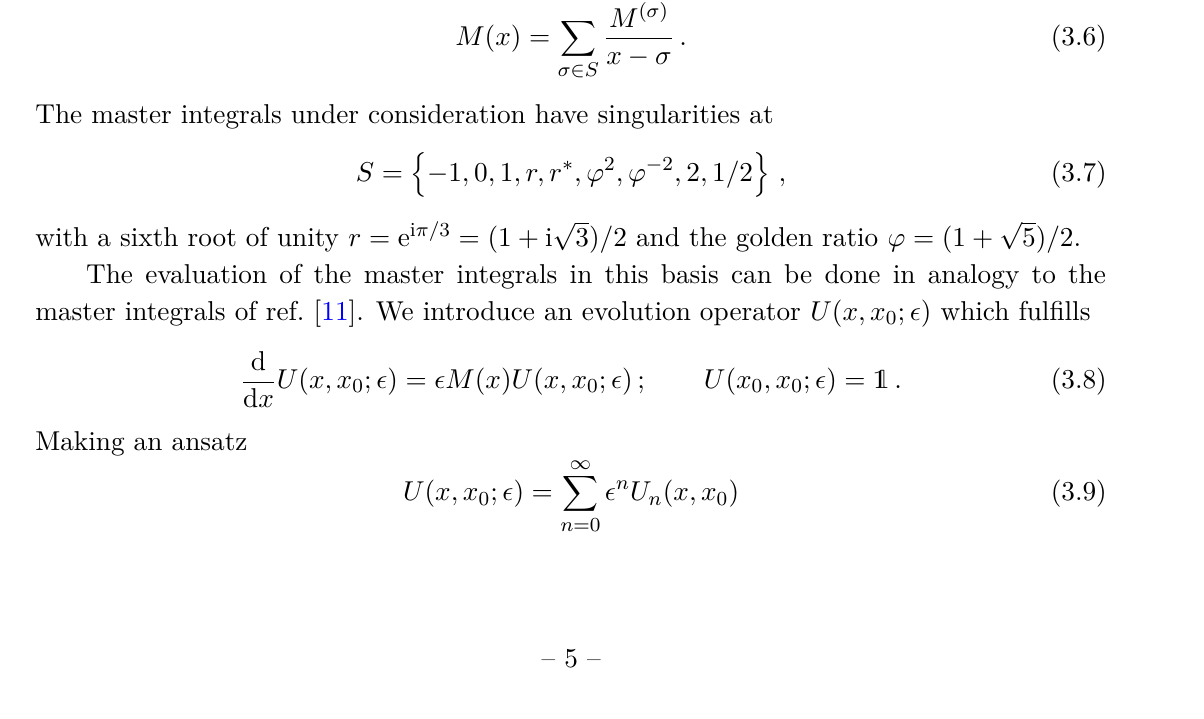
Figure 2. Sample master integrals expressible in terms of GPLs of argument x . Thin lines are massless, bold lines denote propagators with mass m mass M H